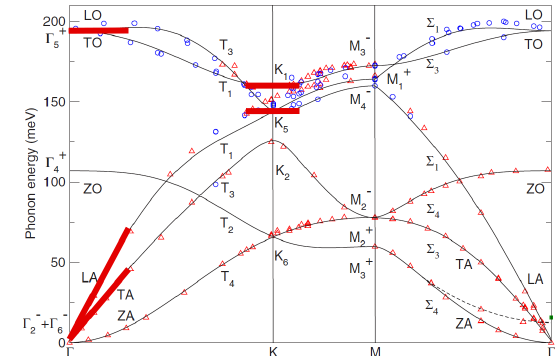
Figure 3: Phonon dispersion of graphene. Phonon energies (cid:126) ω p , µ are shown for of all phonon modes µ with the momentum p along the high-symmetry lines Γ -M-K- Γ . The red lines mark the approxi- mated dispersions used to model the phonons included in the the- ory (LO, TO, LA, and TA). The figure is taken from Ref. [95]. Copyright (2007) by The American Physical